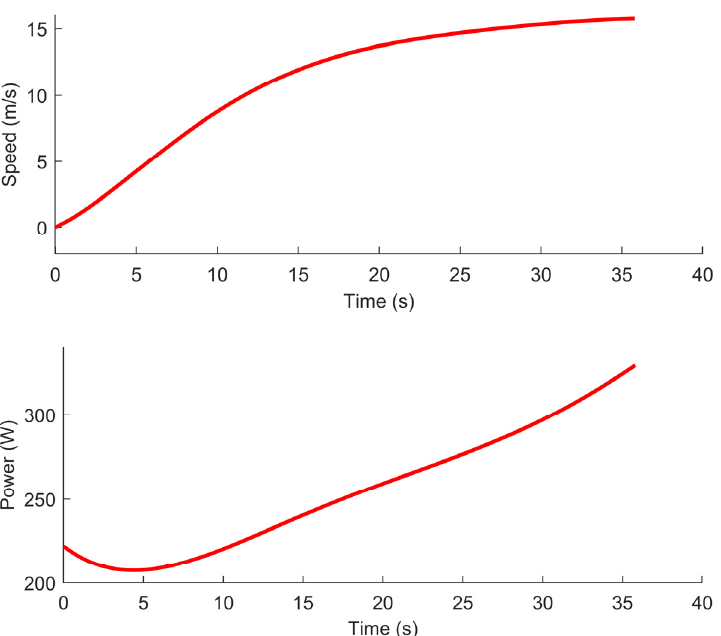
Figure 2. Sixth degree interpolation of the speed and power consumption versus time at maximum acceleration for the IRIS quadcopter with the PX4 autopilot. Calculated using the data published in [23].